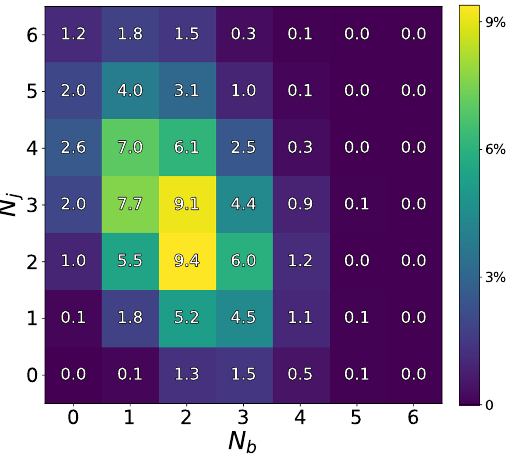
Figure 3 . Signal distribution of the number of reconstructed b -jets, N b , and the number of reconstructed light jets, N j , for the benchmark R 1000 275 25. Shown is the fraction of signal events in